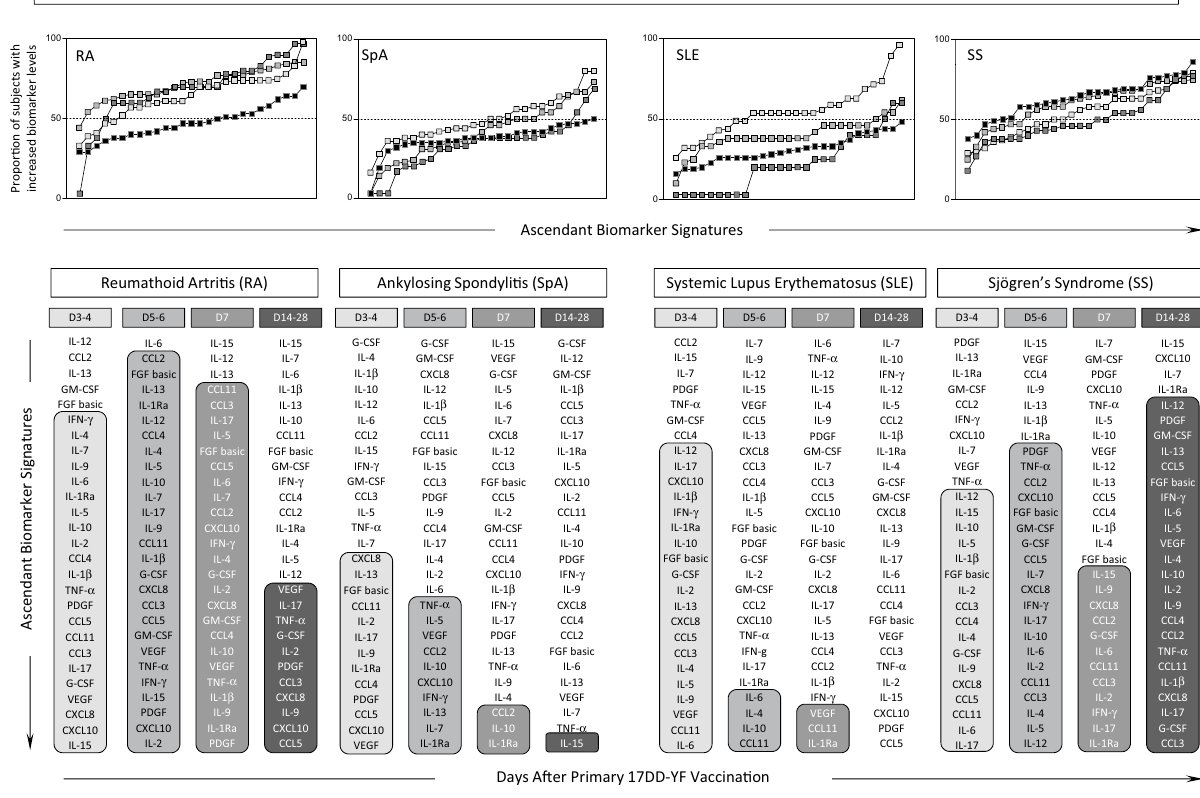
Figure 5. Serum Biomarker Signatures After Planned Primary 17DD-YF Vaccination According to the Type of Autoimmune Disease. Kinetics of serum biomarker signatures at distinct time points after primary 17DD- YF vaccination of Autoimmune Disease patients (D3–4 = light grey filled square, D5–6 = grey filled square, D7 = dark grey filled square and D14–28 = black filled square) categorized according to the type of Autoimmune Disease: Rheumatoid Arthritis (RA, n = 38), Spondyloarthritis (SpA, n = 51), Systemic Lupus Erythematosus (SLE, n = 21) and Sjögren’s Syndrome (SS, n = 30). The results are expressed as the proportion of subjects with increased biomarker levels (baseline fold change values > 1). Data analysis was carried out considering the 50th percentile as the reference to identify the set of biomarkers with high proportion of subjects with levels above the global median cut-off along the kinetic timeline. Those biomarkers with proportion of subjects with levels above the global median cut-off were highlighted with gray scale